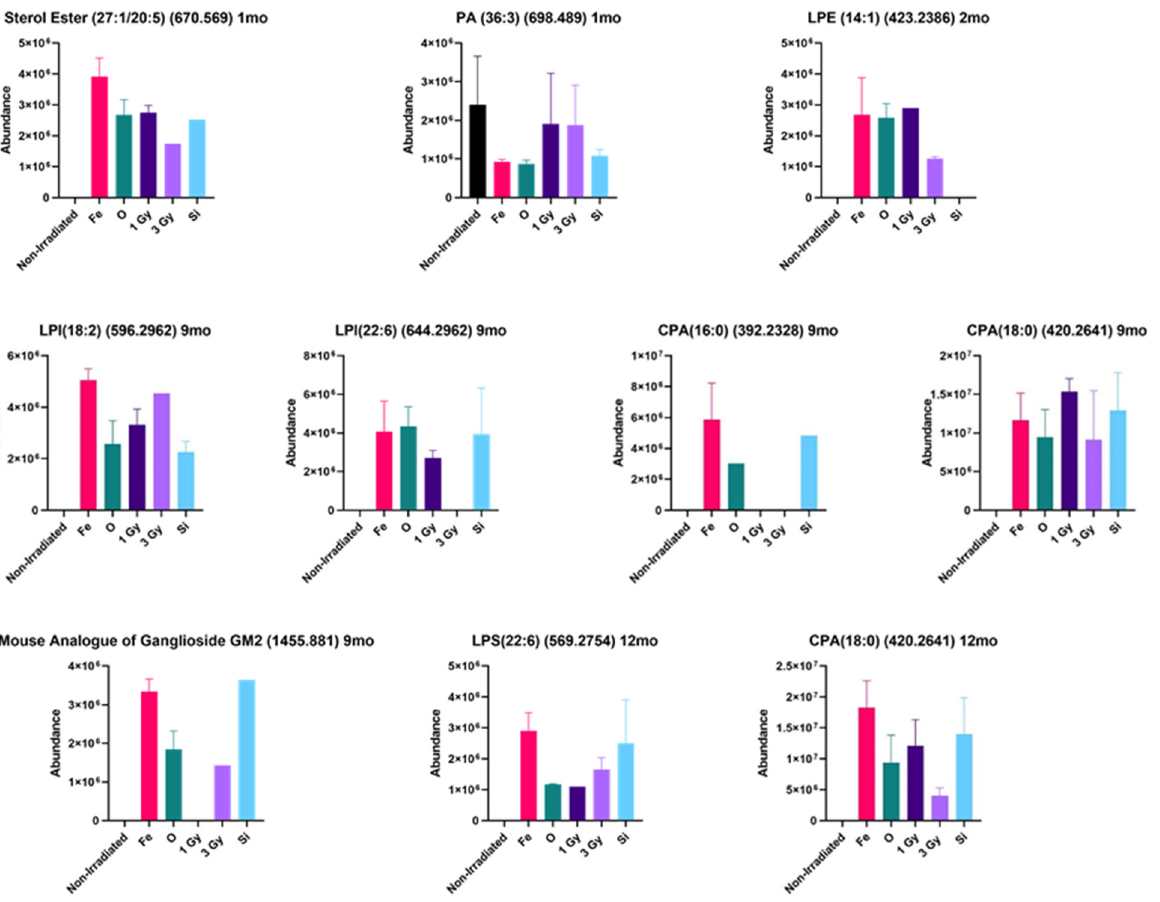
Figure 2. HZE-induced changes in lipid species throughout the time course. Figure 2 shows a representative selection of some of the identified lipids that are biologically linked to mitochondrial function that had modified expression as compared with the non-irradiated control. In many cases, the lipids of interest were not detected in the non-irradiated control, but were highly induced in the livers of the irradiated mice. All data were from a group of 5